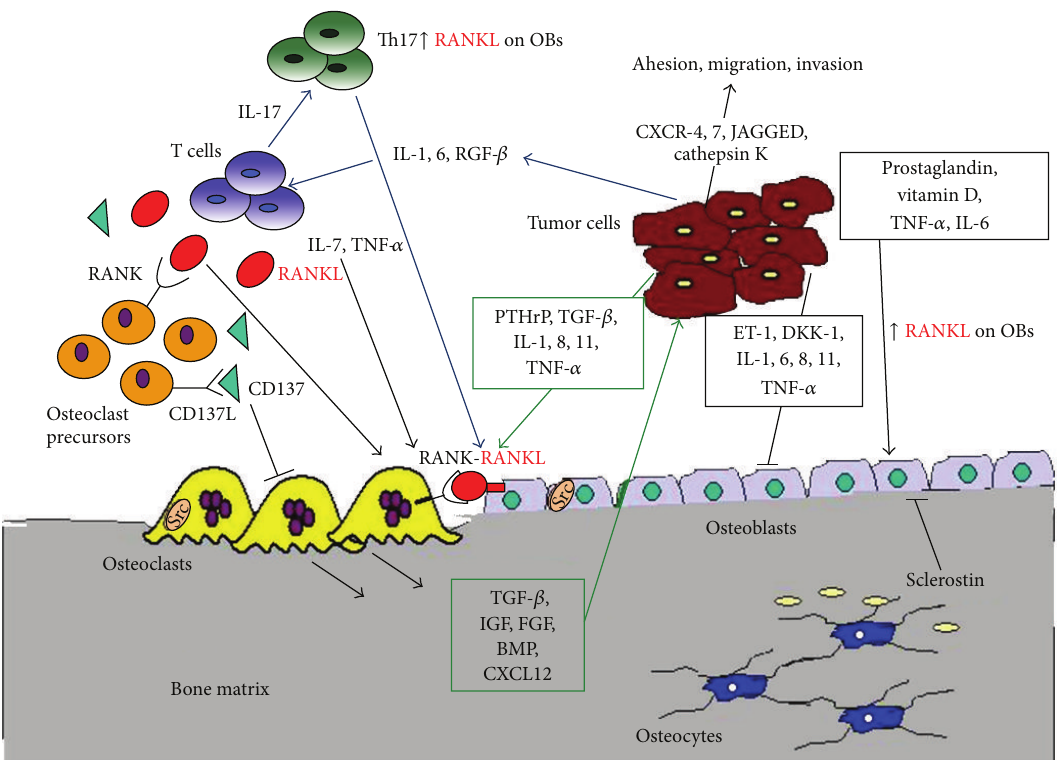
Figure 1: Molecular interactions among bone, tumor, and T